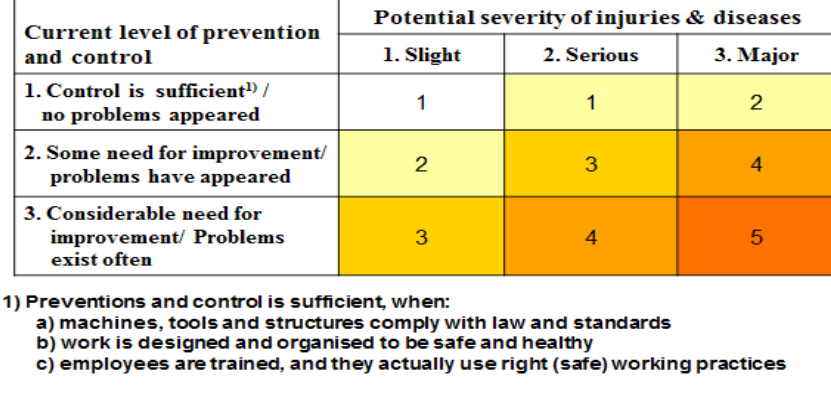
Table 2. The explanations of risk